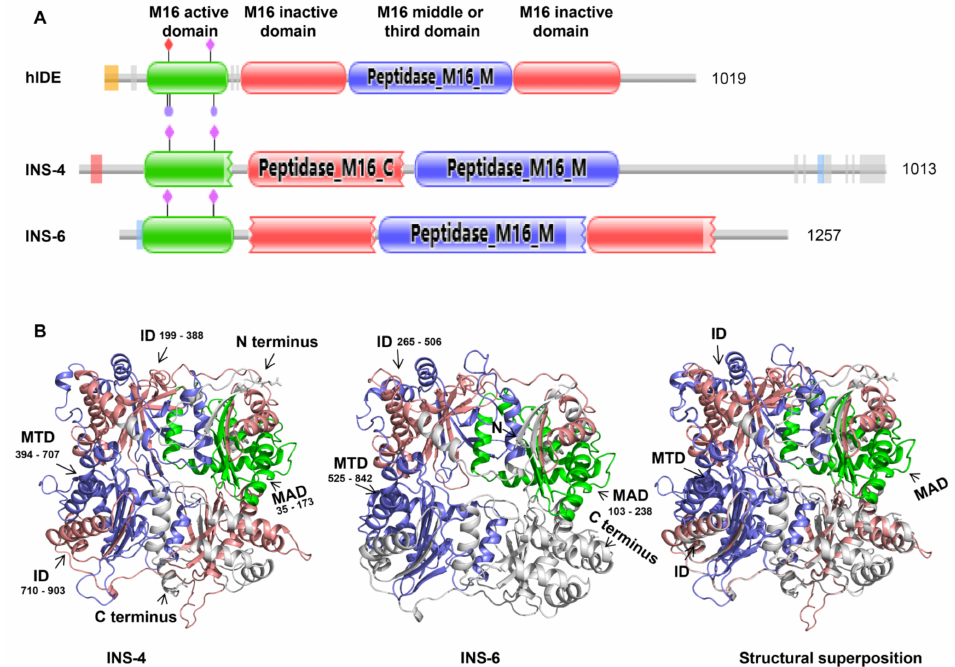
Figure 1. Structure feature of insulinaselike proteases CpINS-4 and CpINS-6 of Cryptosporidium parvum . ( A ) Diagram of domains in CpINS-4, CpINS-6, and human insulin degrading enzyme (hIDE). CpINS-4 has all four domains associated with classic insulin degrading enzymes, while CpINS-6 has an M16 active domain, an inactive domain, and one middle domain. ( B ) Predicted tertiary structures of CpINS-4 (left), CpINS-6 (middle) and structural superposition (right). The ribbon model is colored based on the M16 active domain (MAD), inactive domains (ID), and the middle domain